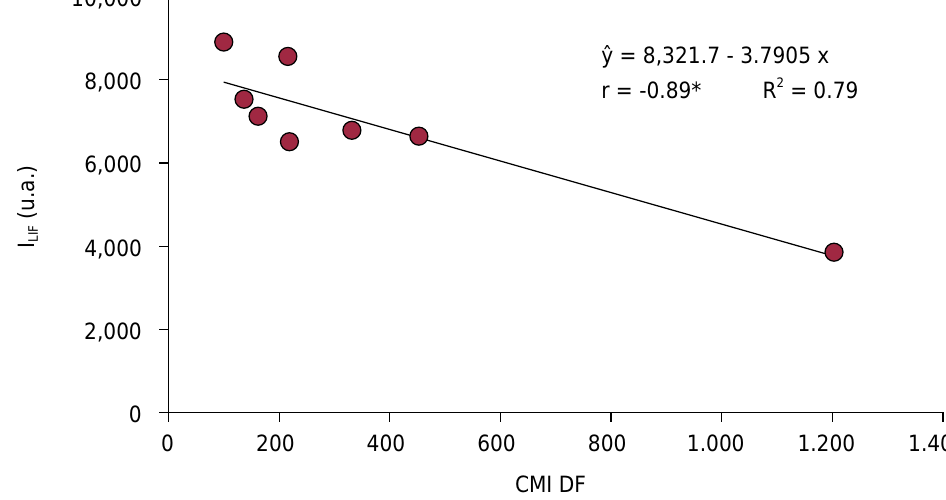
1.40 CMI DF Figure 3. Relationship between the laser-induced fluorescence index (I LIF ) and carbon management index estimated from density fractions (CMI DF) of organic matter in the 0.00-0.03 m layer of a constructed soil covered with different grass species, a bare constructed soil and a natural soil (unmined, with native vegetation). *: significant, p<0.01.